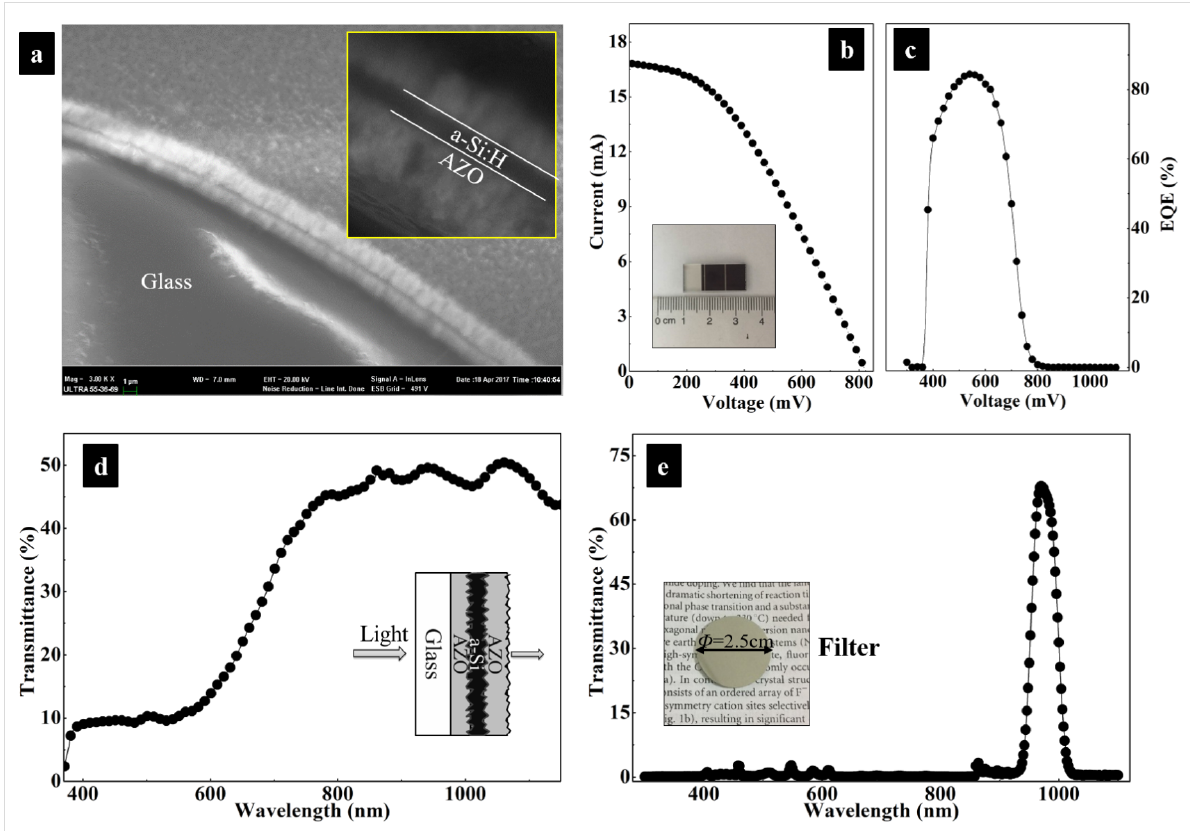
Figure 3: (a) FE-SEM images showing the multiple layers of a-Si:H solar cell; (b) current–voltage and (c) EQE curves of a-Si:H solar cell under AM1.5 solar irradiation. (d) transmittance spectrum of a-Si:H solar cell without reflector in 370–1100 nm; (e) transmittance spectrum of the optical filter and the inset optical